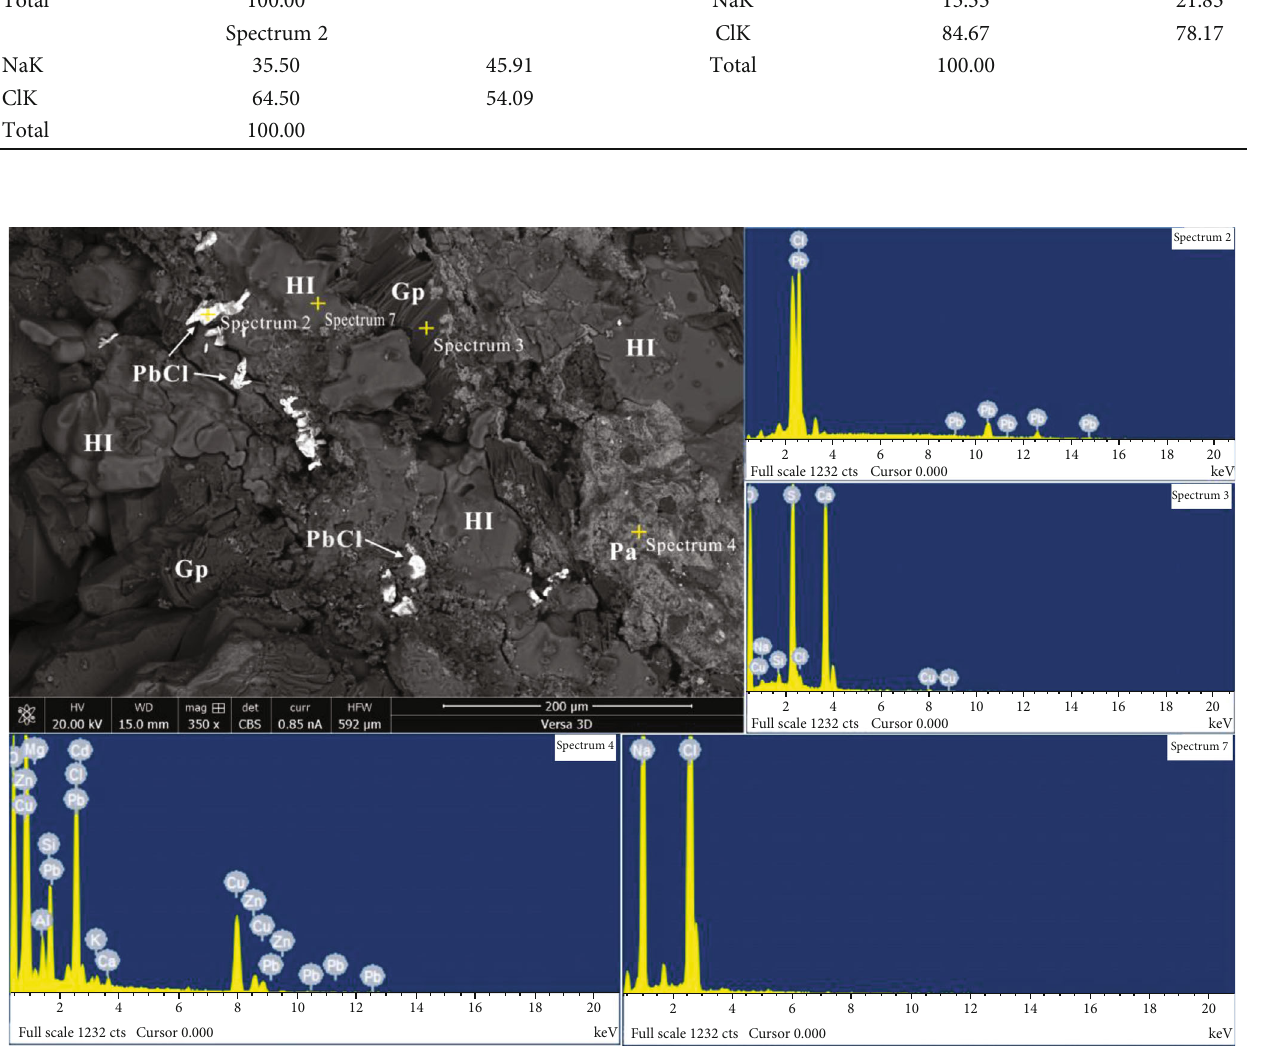
. The upper left is a BSE image whereas the rest of the graphs are EDS spectrums. Gp: 3 . The white mineral, containing Cu, 2 (OH) Cl) and may contain clay minerals, Zn and Pb. The grey mineral 2 3 · 2H 4 2